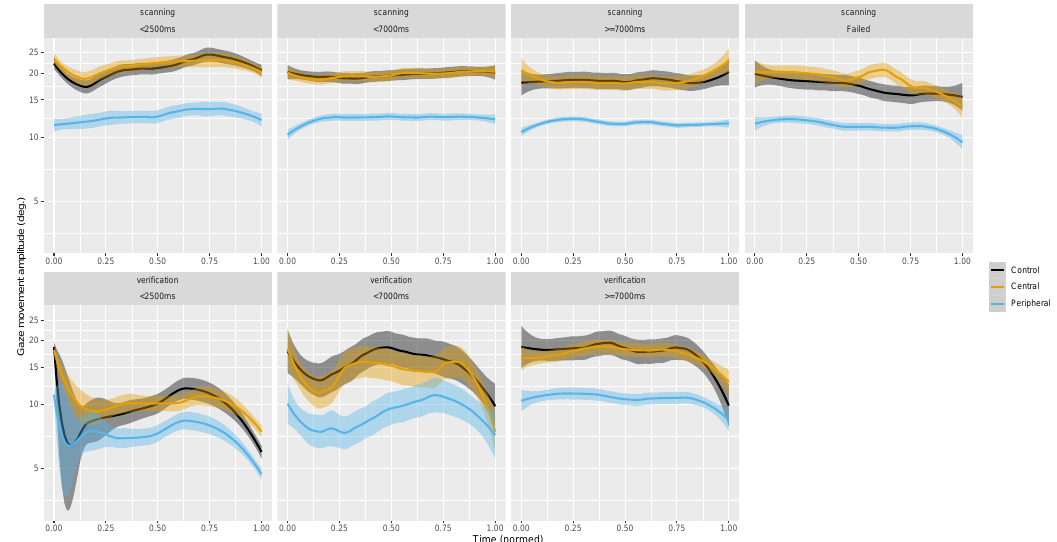
Figure A5. Time-course of average gaze movements amplitude during saccades as a function of search phase (trial duration subgroups do not overlap). Ribbons show 95%CI. Control condition appears in black, central in orange and peripheral in blue.